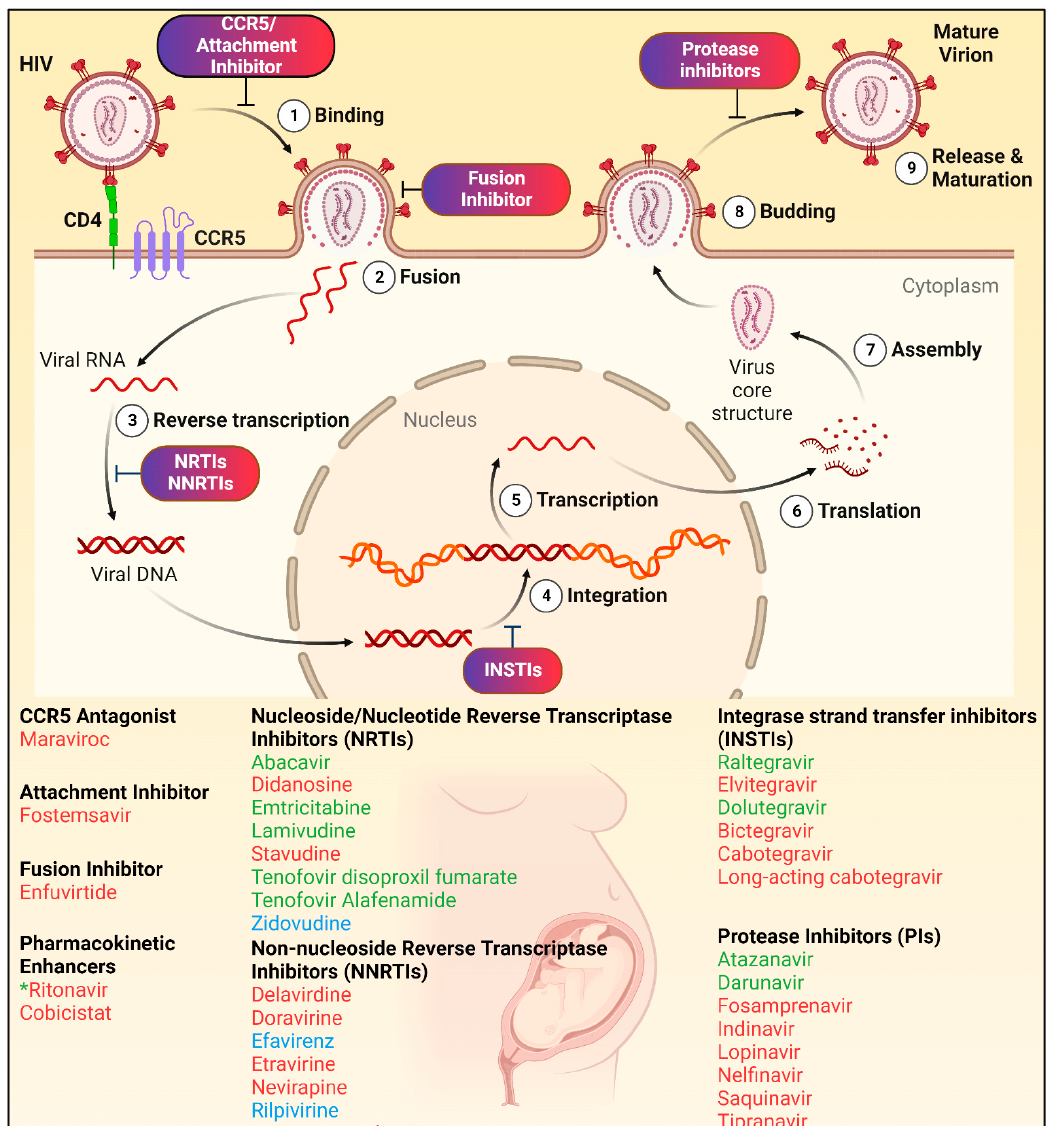
Figure 3. Overview of HIV-1 life cycle and antiretroviral drugs during pregnancy. HIV-1 life cycle is classified into nine major steps include binding, fusion, reverse transcription, integration, transcription, translation, assembly, budding and maturation. Each step of the HIV-1 life cycle is a potential target for antiretroviral drugs (ARVs). A list of current the recommendations for use of ARVs for infected pregnant women who have never received ARVs before (ARV-naïve), set by the United States Department of Health and Human Services (DHHS) Panel on Treatment of HIV During Pregnancy and Prevention of Perinatal Transmission, is provided. Recommended categorization of individual ARVs is as preferred , alternative , or not recommended . Preferred ARVs: highlighted in green color, Alternative ARVs: highlighted in blue color, and Not recommended ARVs: highlighted in red color. * Note: Ritonavir (RTV) is only preferred when used as a pharmacokinetic (PK) booster for PIs include darunavir (DRV) and atazanavir (ATV) during pregnancy.